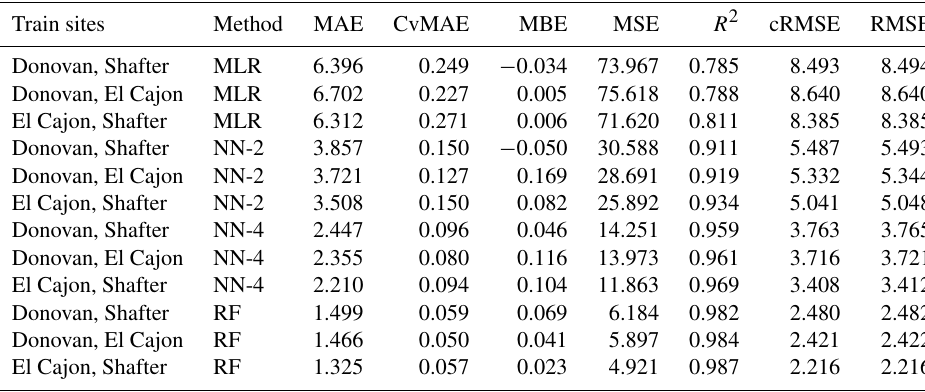
Table C11. Level 2 train results for O 3 (train and test on the same data set).